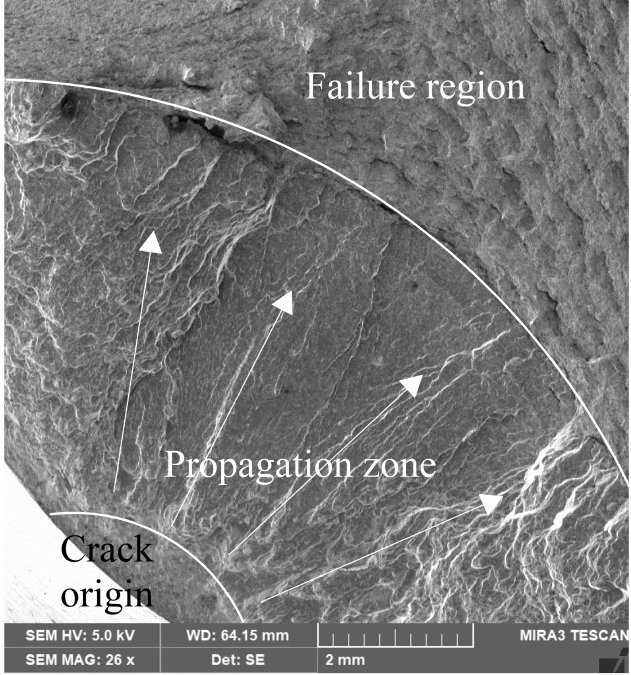
Figure 8. SEM image of the fracture surface morphology of the specimen of 12 mm in